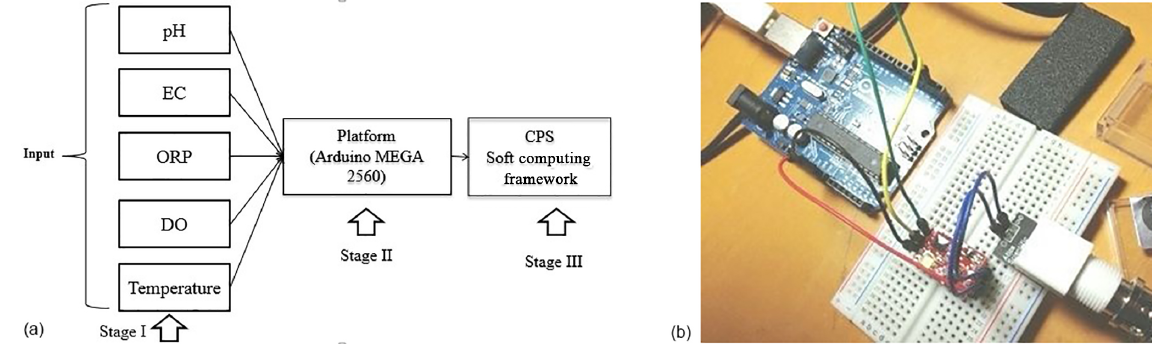
Table 1. Targeted water quality parameters.